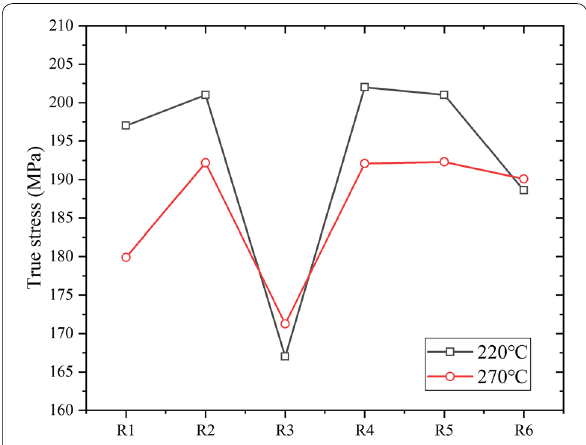
Figure 8 Critical stress values of different regions along the transverse